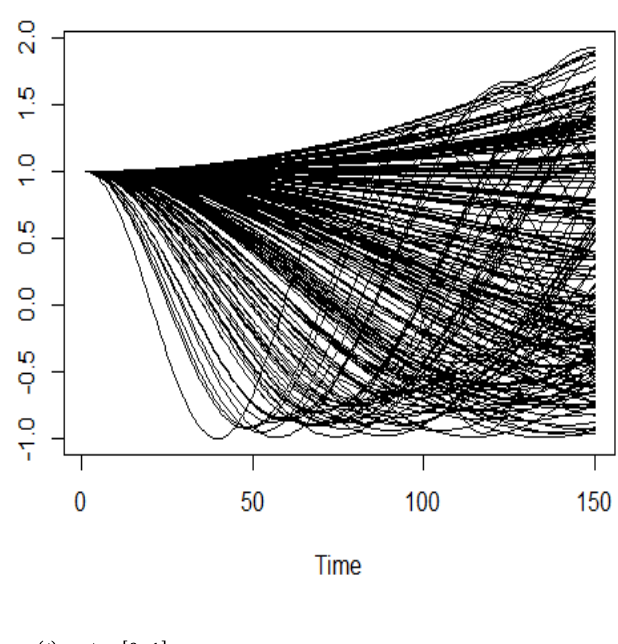
Figure 10: The curves X i =1, ... ,200 ( t ), t ∈ [0, 1].